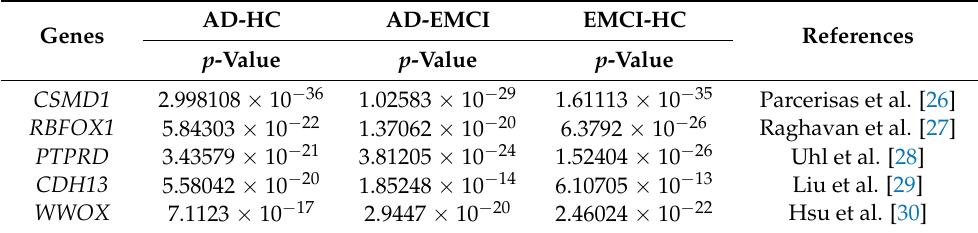
Table 3. Significant genes in the three